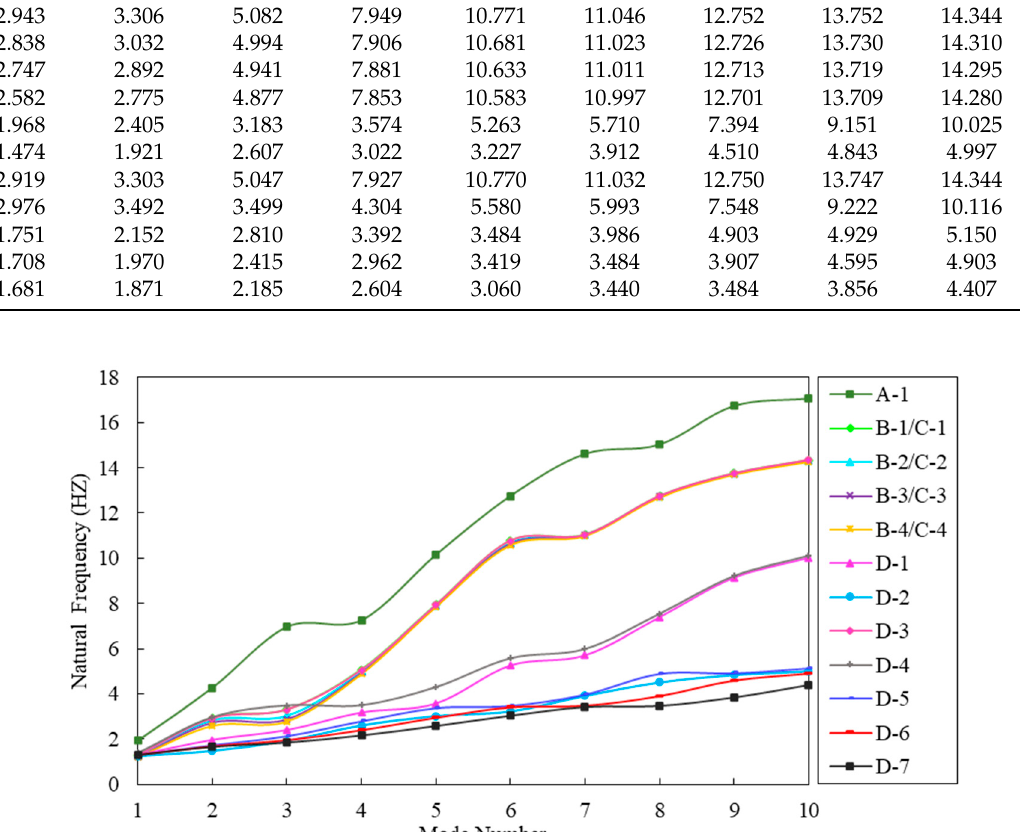
Figure 9. The distributions of the first ten natural frequencies of the